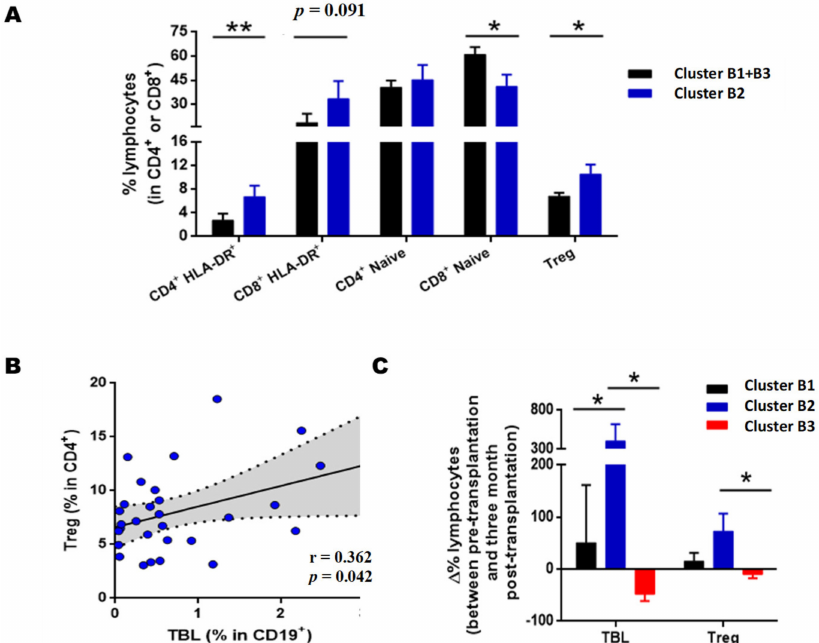
Figure 6. T cell phenotype of clusters B1, B2, and B3. ( A ) Relative frequencies of activated HLA-DR+, naive and regulatory T lymphocytes (Tregs) at three months post-transplantation of clusters B1 + B3 and B2. Comparisons made using the Mann–Whitney U test. ( B ) Correlation between levels of Treg and transitional B lymphocytes (TBL). Analysis performed using the Spearman index. The r corresponds to the correlation coefficient, and the shaded area indicates the 95% confidence interval. ( C ) Percentage variation of the levels of TBL and Treg between pre-transplantation and three months after-transplant. Comparisons made using the Kruskal–Wallis test and Dunn’s post hoc test with Bonferroni correction for multiple comparisons. Values expressed as the mean ± SEM. p values < 0.05 were considered statistically significant for all analyses. * p < 0.05; ** p <